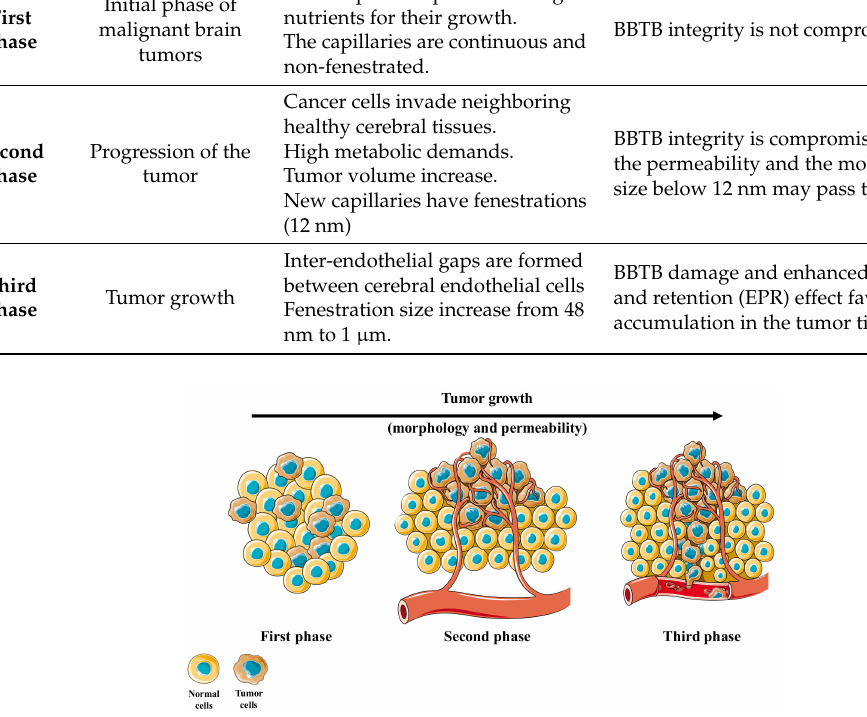
Figure 3. Morphology and permeability phases of the